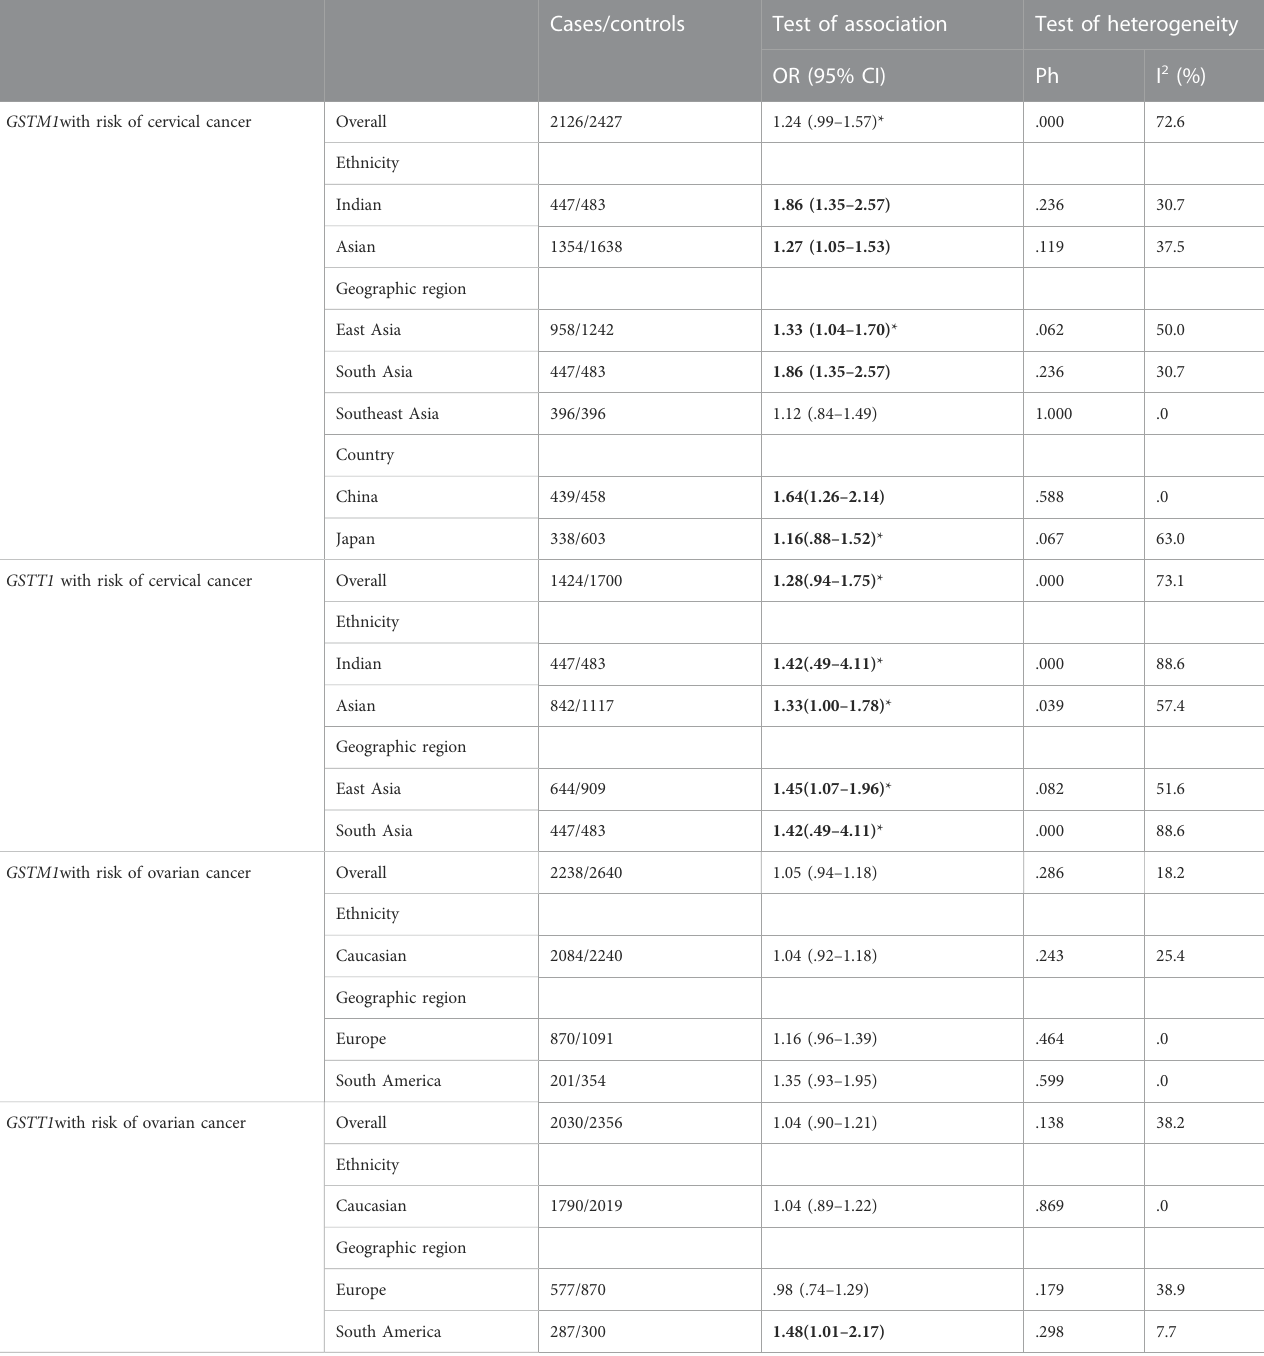
TABLE 9 Pooled estimates of the association of GSTM1 , GSTT1 polymorphism with risk of cervical cancer or ovarian cancer. Exclude low-quality and small sample-